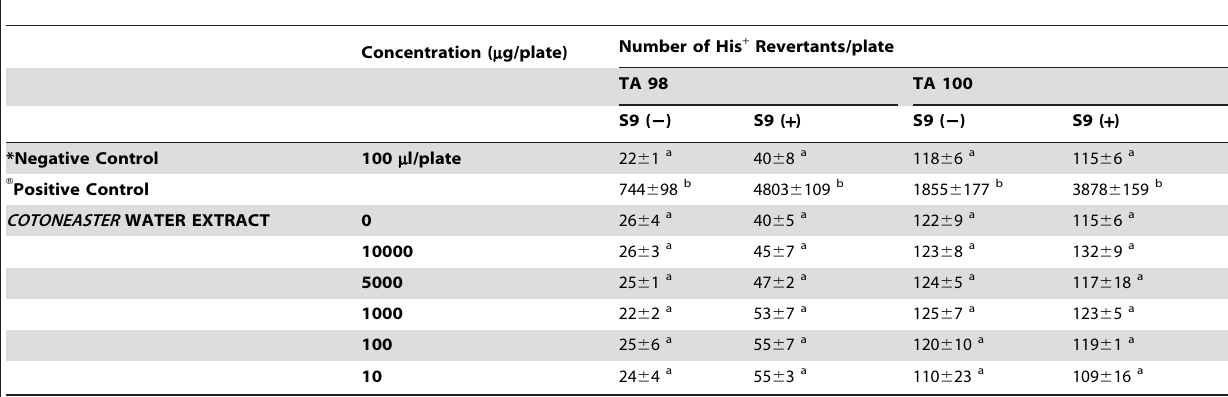
Table 5. Mutagenicity of Cotoneaster extract towards S. typhimurium TA98 and TA100 strains with or without S9.